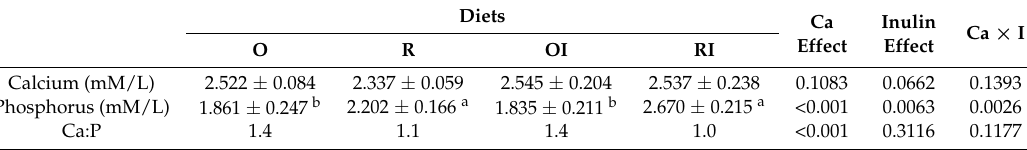
Table 6. Plasma calcium and phosphorus concentration in rats fed experimental GFDs *.